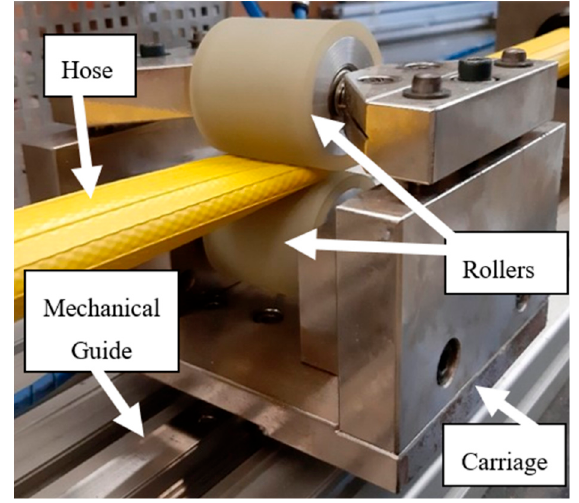
Figure 1. Pneumatic linear peristaltic actuator.